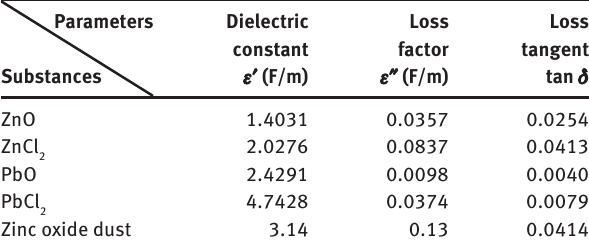
Table 2: Dielectric parameters of different substances. Parameters